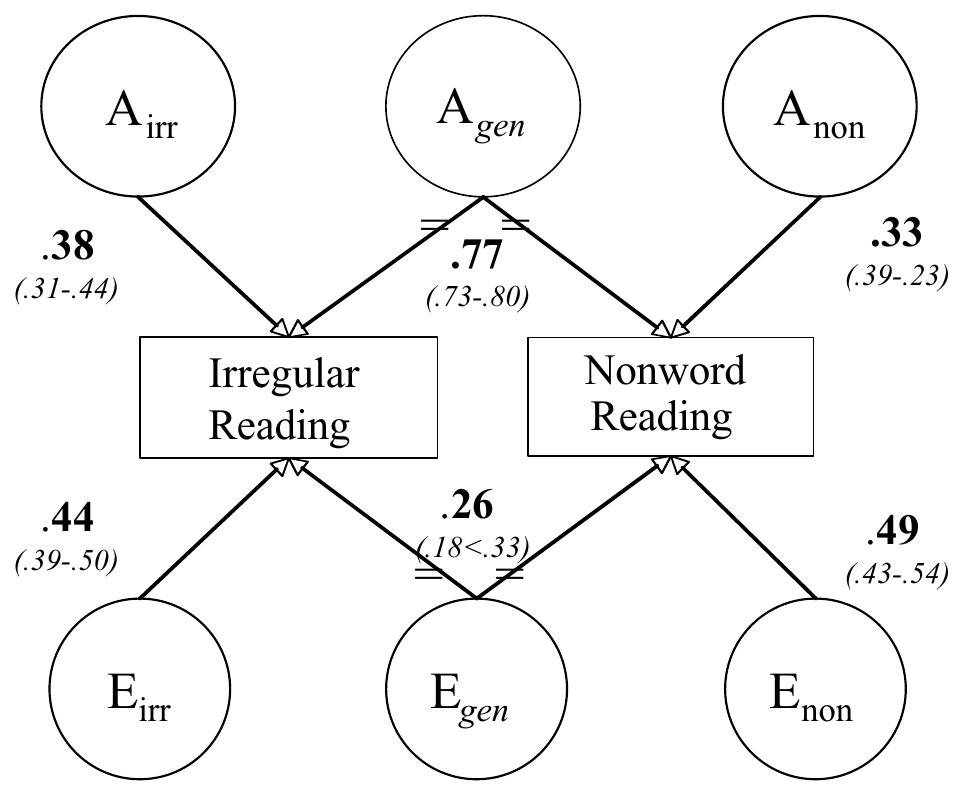
Figure 2. A dual route genetic model of reading (from Bates et al ., 2006, with